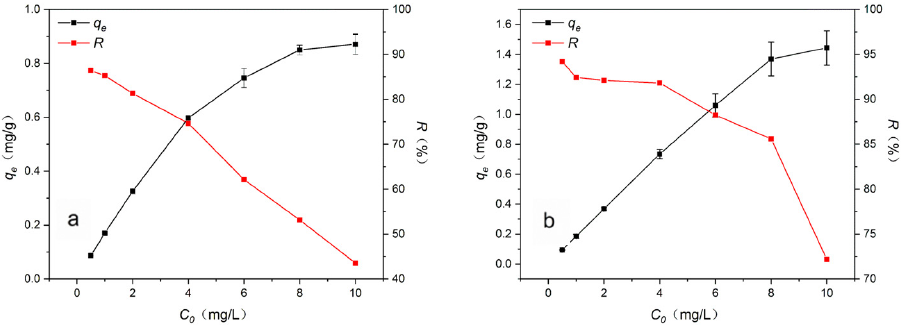
Figure 8. Effects of initial concentration of ( a ) bifenthrin and ( b ) cypermethrin on adsorption capacity and removal efficiency.